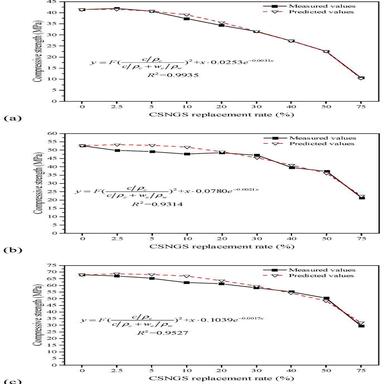
Comparison between measured values and predicted values of the mortar compressive strength, (a) 7 d (b) 28 d (c) 90 d.